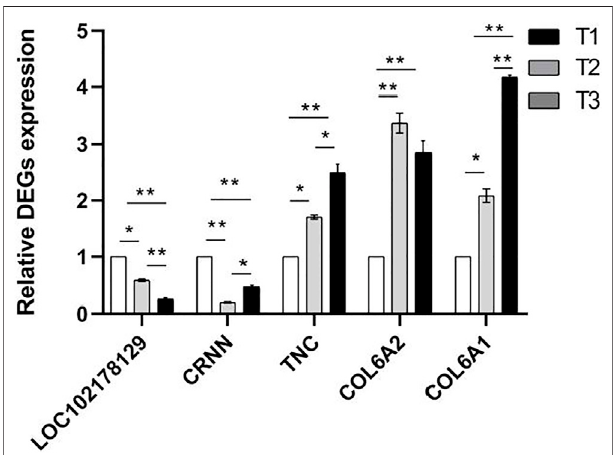
FIGURE 10 | Relative mRNA expression levels of proteins using qPCR method. NOTE: * means p < 0.05, ** means p <